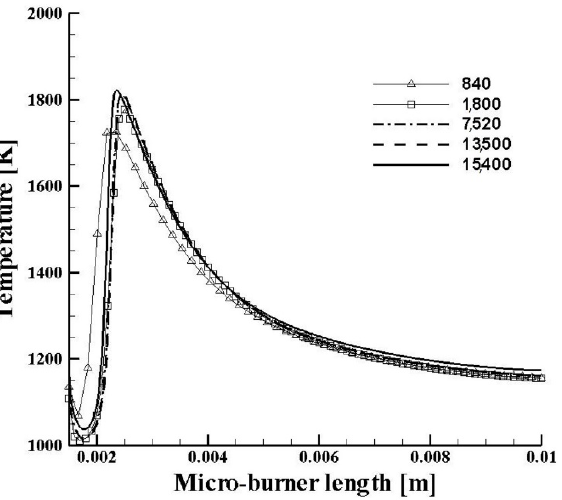
Figure 2. The studied computational mesh; temperature distribution on the auxiliary axis of r = 0.3 mm.